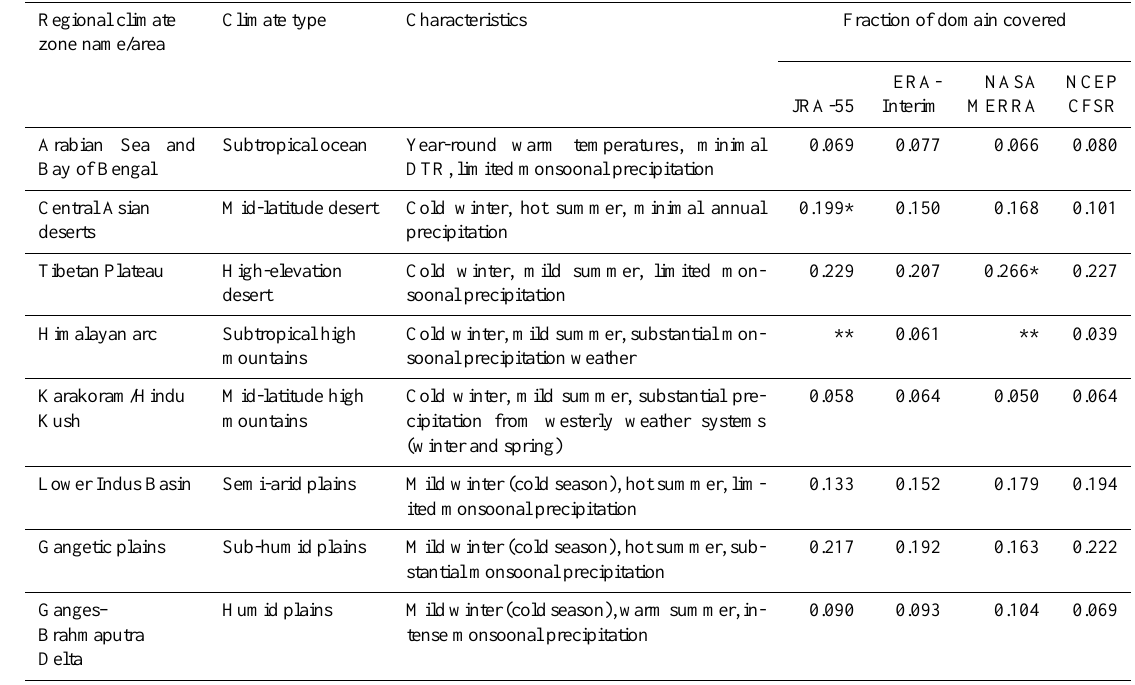
Table 4. Description of primary Himalayan region climate zones (eight